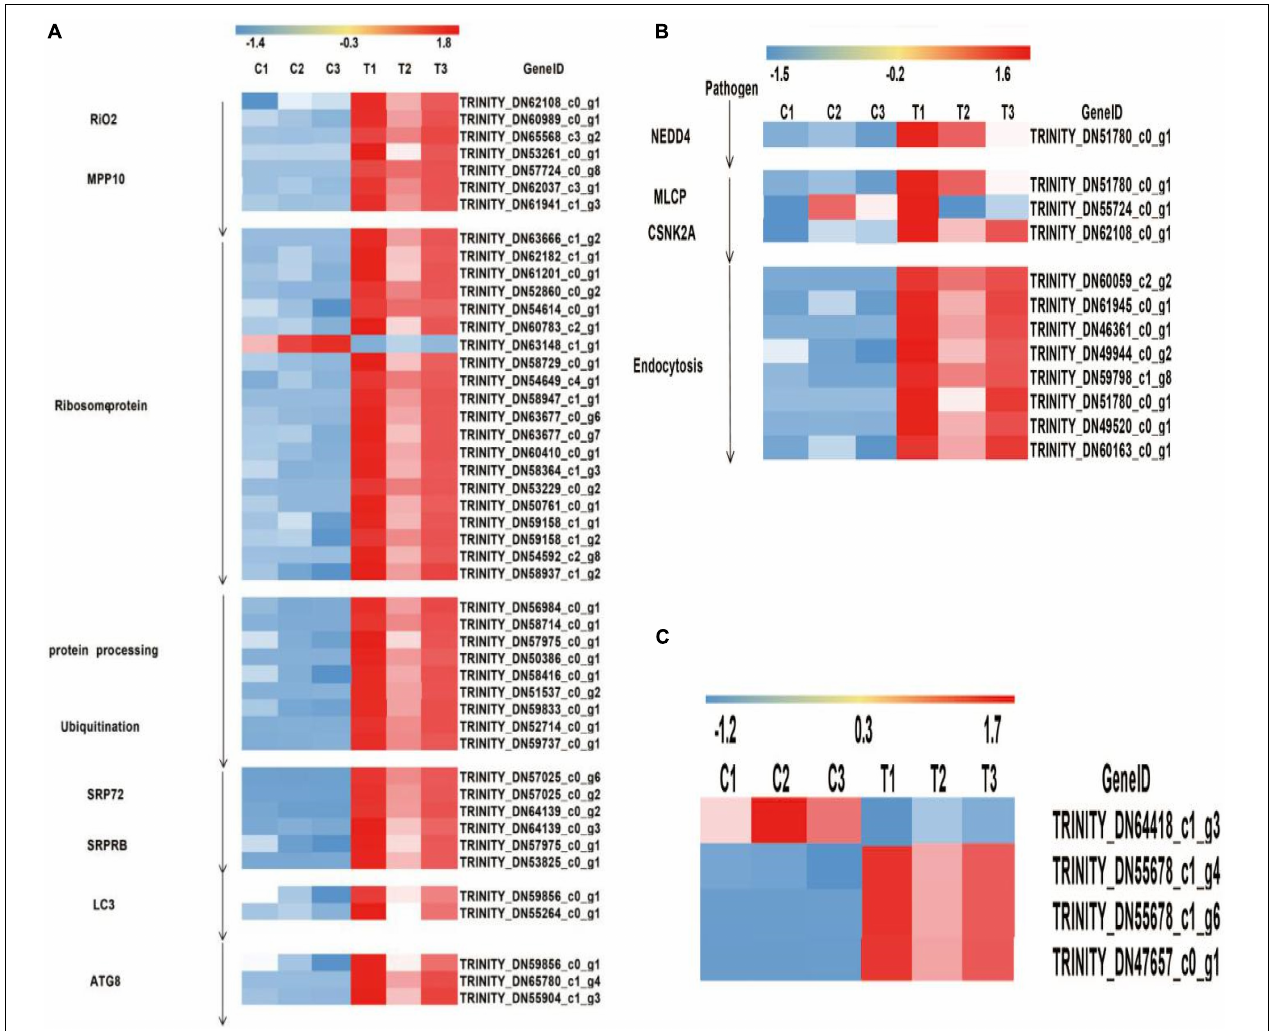
FIGURE 3 | Heat map diagrams of relative expression levels of DEGs in response to plants under infection of ScYLV. (A) Heat map diagrams of relative expression levels of viral protein synthesis and endoplasmic reticulum stress response-related genes in plants. RIO2, RIO protein kinase right open reading frame 2; MPP10, M-phase phosphoprotein 10; SRP72, signal recognition particle 72; SRPRB, Recombinant Signal Recognition Particle Receptor B; LC3, microtubule-associated proteins light chain 3; ATG8, Autophagy-related protein 8. (B) Heatmap diagrams showed relative expression levels of twelve endocytosis genes in plants. NEDD4, E3 ubiquitin-protein ligase; MLCP, myosin light chain phosphatase; CSNK2A, casein kinase II subunit alpha. (C) Heat map diagrams of relative expression levels of PEX proteins. PEX5, peroxisomal biogenesis factor 5; PEX10, peroxisomal biogenesis factor 10; PEX13, peroxisomal biogenesis factor